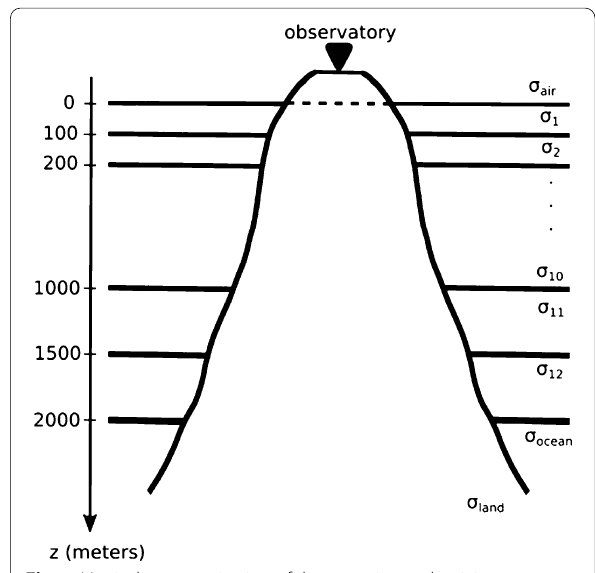
Fig. 4 Vertical parametrization of the oceanic conductivity distribution in the 3-D modeling domain. σ 1 to σ 12 are the respective water layer’s conductivities, set to the layer’s average conductivity calculated from the global ocean conductivity model. σ ocean is the deep (below 2000 m) ocean conductivity, which is set to 3.2 S/m. σ land and σ air are the landmass and air conductivity set to 0.01 S/m and 10 − 8 S/m,